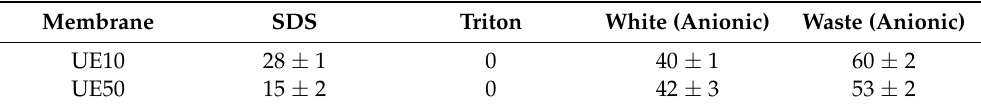
Membrane SDS Triton White (Anionic) Waste